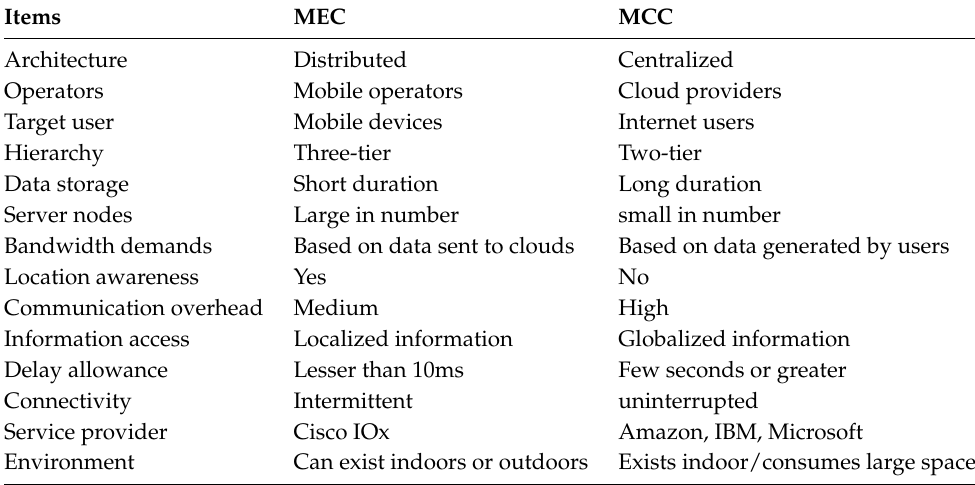
Table 6. A detail comparison between Mobile Cloud Computing (MCC) and Multi-access Edge Computing (MEC)